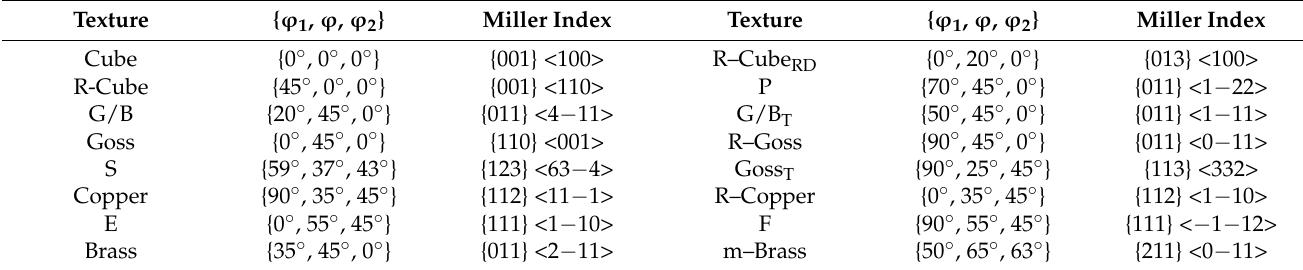
Figure 2. ( a ) Grain structures, histograms of grain size and histograms of the misorientation angle of the samples annealed at ( a ) 150 ◦ C, ( b ) 350 ◦ C and( c ) 400 ◦ C before thermal cycling. Dark lines correspond to HAGBs and white to LAGBs. Table 1. Detailed parameters of the common texture components in the aluminum